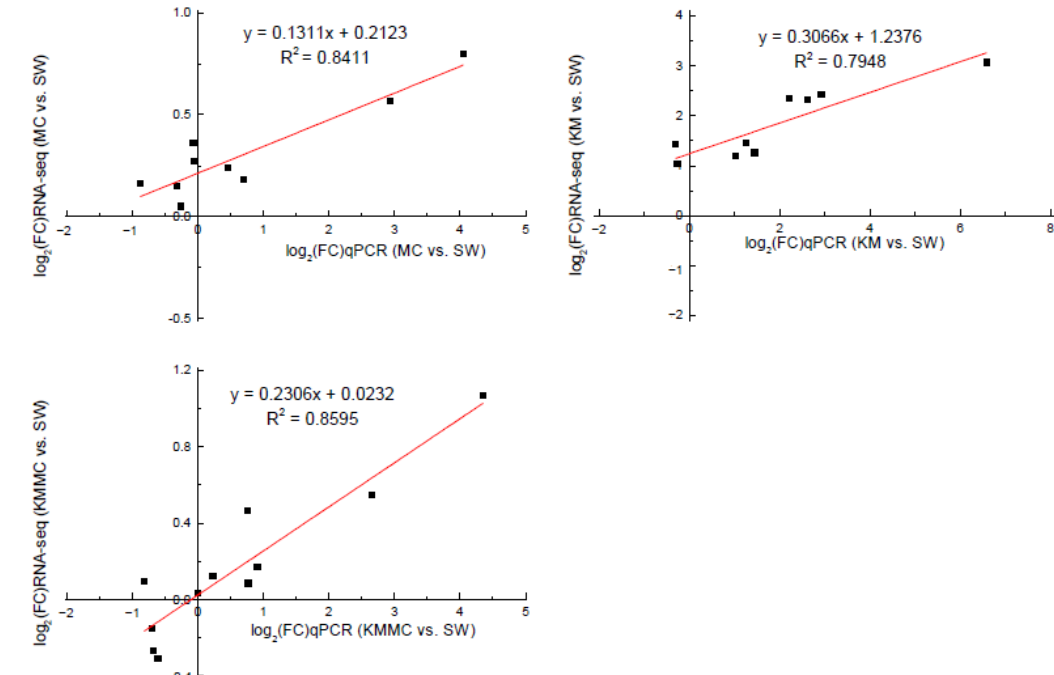
Figure 8. Correlation analysis between RNA ‐ Seq and qRT ‐ PCR validation results of genes.